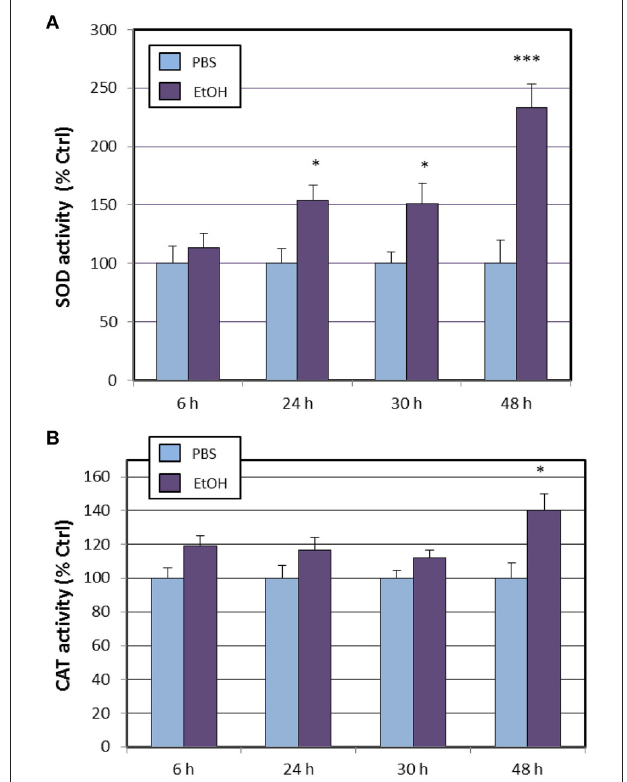
FIGURE 1 | Effects of ethanol (EtOH, 0.1%) on total SOD (A) and catalase (B) activities in HT22 cells at different times after first exposure to ethanol. Results correspond to the mean ± SEM of four different experiments. *, and *** p < 0.05 and p < 0.005 compared to vehicle (PBS),